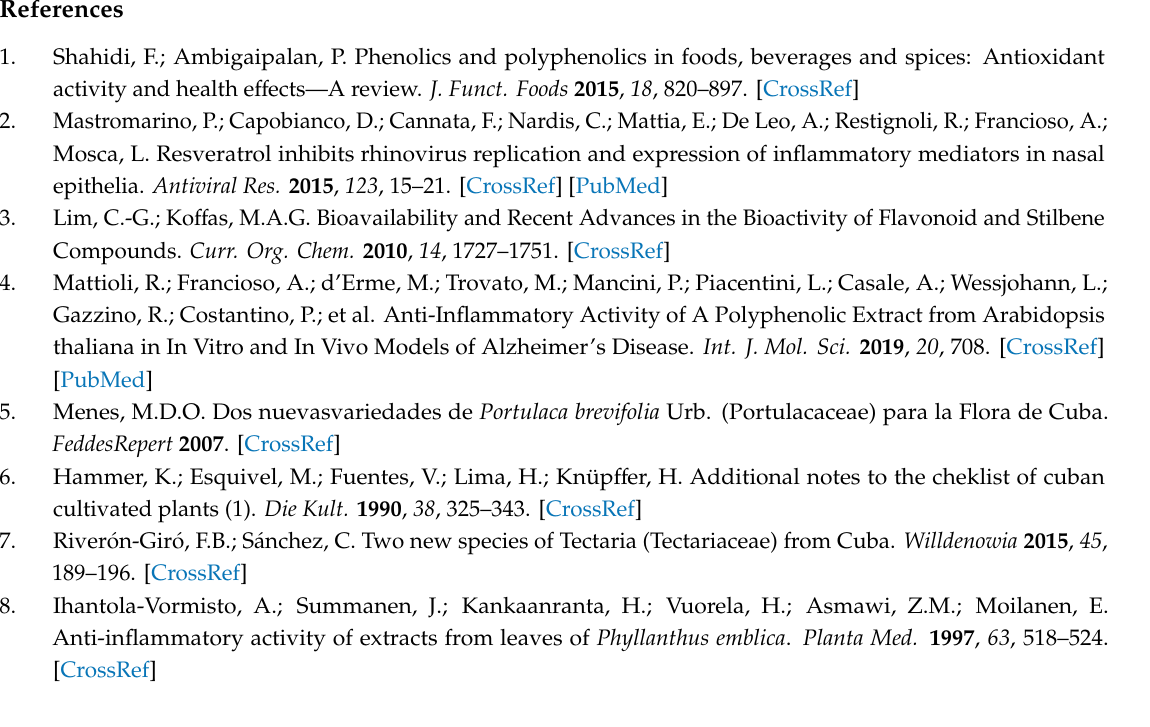
Table S1: DFT calculations for (2S,3S)